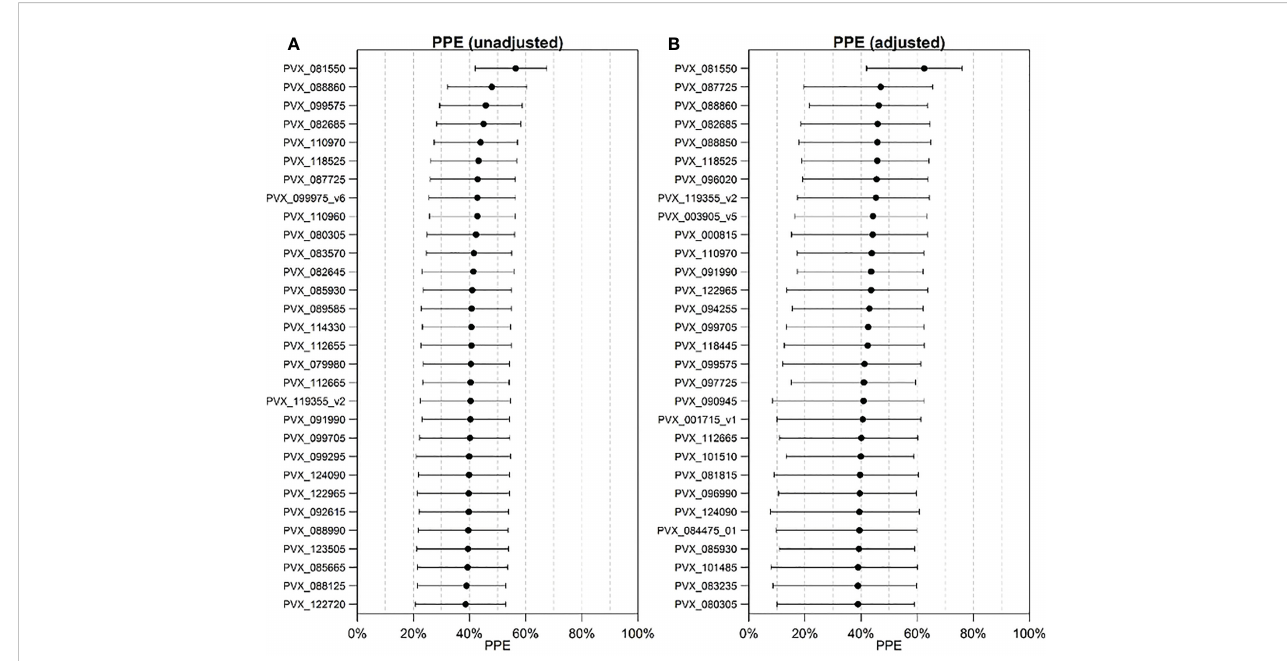
FIGURE 2 Estimated potential protective ef fi cacy (PPE) for the top 30 P . vivax proteins. (A) unadjusted analysis using logistic regression and (B) adjusted analysis using a GEE